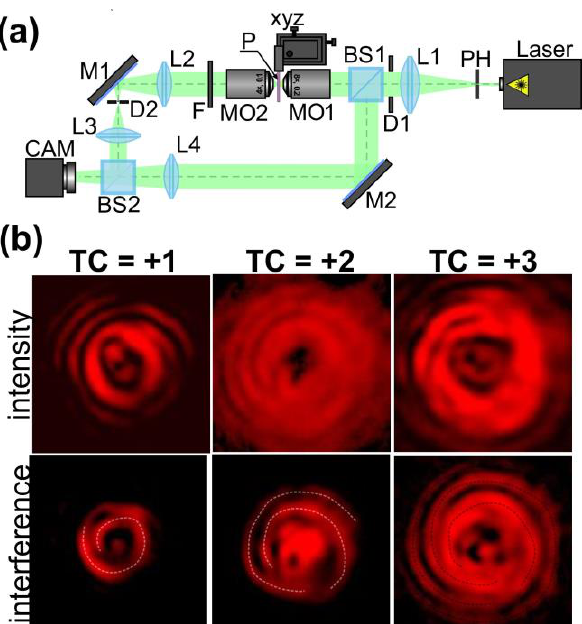
Figure 5. Generation of OAM laser beams with the multi-spiral microstructures fabricated using direct multi-spiral laser patterning in azopolymer thin films. ( a ) The experimental setup for the investigation of the light field formed because of the diffraction of a linearly polarized Gaussian beam on the fabricated microstructures. Laser is a He-Ne ( λ = 633 nm, P out = 1 mW); PH is a pinhole (aperture size 40 µ m); L1, L2, L3, and L4 are spherical lenses ( f 1 = 250 mm, f 2 = 150 mm, f 3 = 100 mm, f 4 = 150 mm); M1 and M2 are mirrors; D1 and D2 are circular diaphragms; BS1 and BS2 are beam splitters; MO1 and MO2 are microobjectives (3.7 × , NA = 0.1 and 4 × , NA = 0.1); P is a glass substrate with fabricated multi-spiral microstructures in an azopolymer thin film; F is a neural density filter; and CAM is a video camera (TOUPCAM UHCCD00800KPA; 1600 × 1200 pixels with a pixel size of 3.34 µ m). ( b ) Intensity distributions and interference fringes generated at a distance of 30 µ m from the surface of the used azopolymer thin film. Three different multi-spiral microstructures fabricated using OVs with TCs +1, +2, and +3 were investigated. The dotted curves indicate formed spiral interference fringes. The image dimensions are 50 × 50 µ m 2